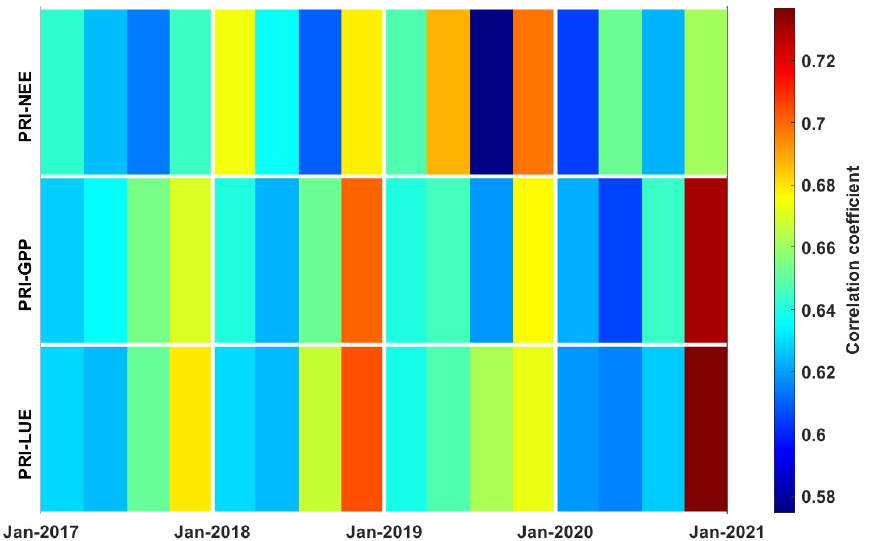
Figure 5. Seasonal mean values of daily Person correlation coefficients between half-hourly PRI and carbon-related variables from January 2017 to December 2020. For better comparison, absolute values of correlation coefficients were shown in the figure. PRI = photochemical reflectance index; LUE = light use efficiency; GPP = gross primary production; NEE = net ecosystem exchange.